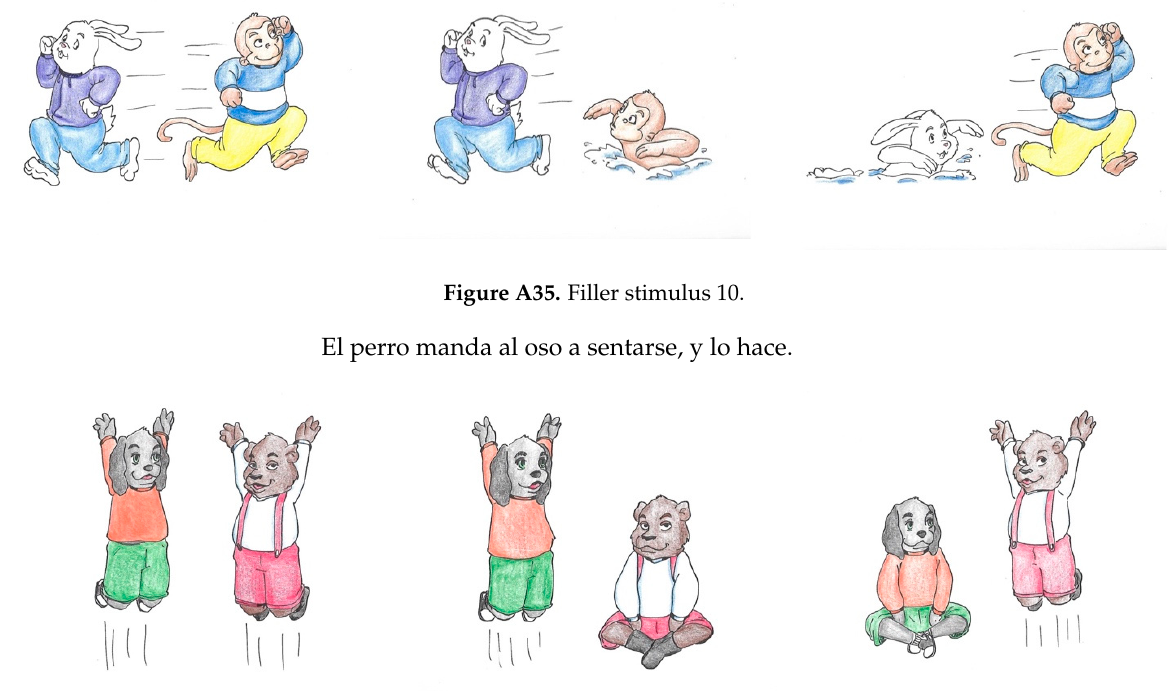
Figure A36. Filler stimulus 11.